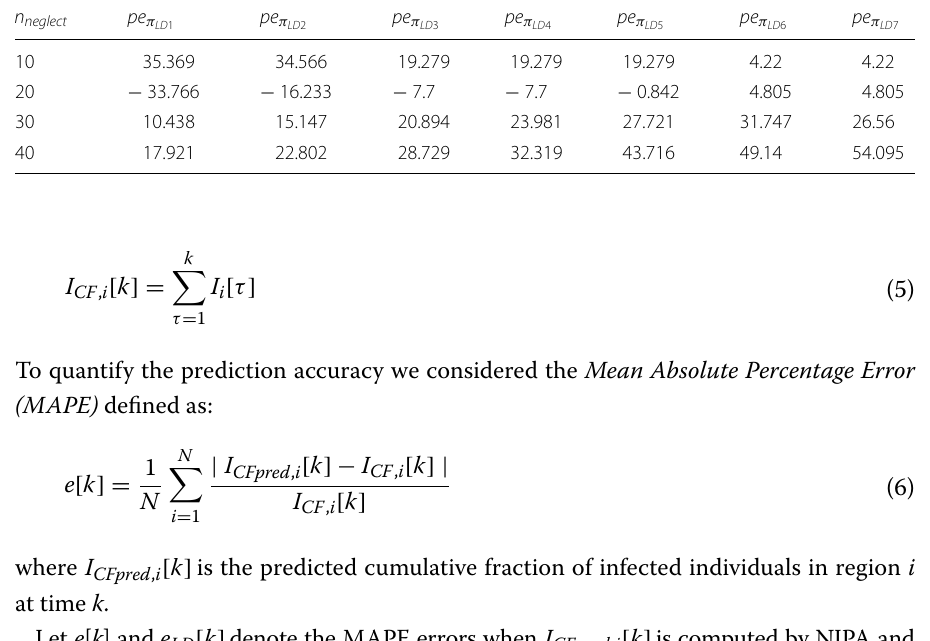
Table 1 Percentage improvement of NIPA‑LD over NIPA prediction for different transmission modifier values and increasing number of neglected days n